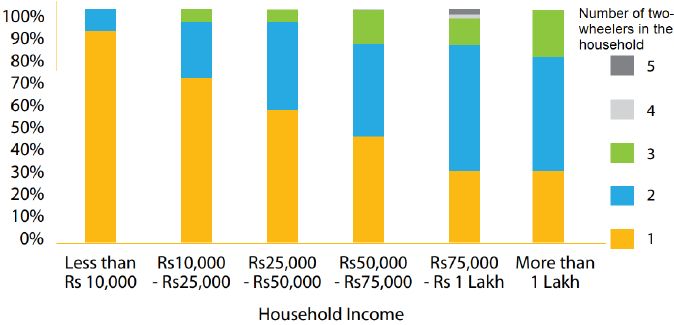
Figure 8. Two-wheeler owners’ monthly household income and household size [53].